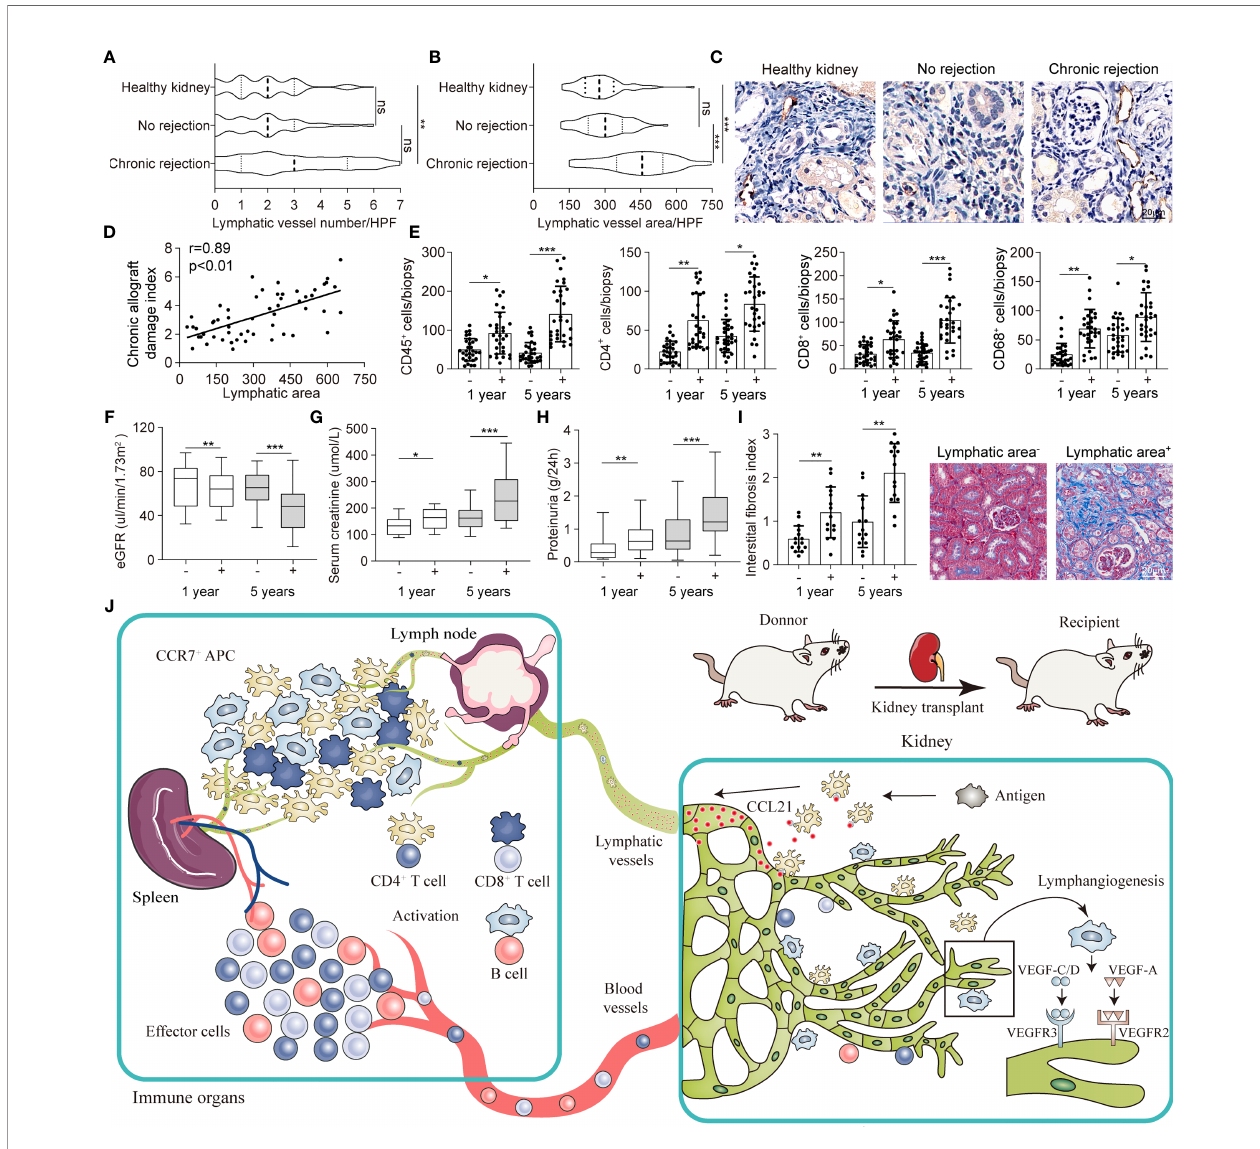
FIGURE 6 | Intrarenal lymphangiogenesis negatively correlated with allograft function in transplant patients. (A, B) Lymphatic vessels number and area counted in high-power fi eld (HPF) respectively in healthy (n=11), no rejection (n=80) and chronic rejection kidneys (n=54) from patients. (C) Representative images of immunohistochemical staining of LYVE-1 in healthy, no rejection and chronic rejection kidneys from patients to identify the situation of lymphangiogenesis. (D) Linear regression graph of chronic allograft damage index and lymphatic area. (E) Cell counting of different immune cells, include CD45 + (myeloid cells), CD4 + (Th cells), CD8 + (CTL cells), CD68 + (macrophage), in lymphatic area + (de fi ned as lymphatic vessels area more than 458.74 m m 2 ) and lymphatic area - (de fi ned as lymphatic vessels area less than 458.74 m m 2 ) group from chronic rejection kidneys at 1 year and 5 years determined by fl ow cytometry. (F) Quantitative data of eGFR ( m L/min/ 1.73m 2 ) in lymphatic area + (n=36) and lymphatic area - (n=18) group from chronic rejection kidneys at 1 year and 5 years. (G) Quantitative data of serum creatinine ( m mol/L) in lymphatic area + and lymphatic area - group from chronic rejection kidneys at 1 year and 5 years. (H) Quantitative data of proteinuria (g/24h) in lymphatic area + and lymphatic area - group from chronic rejection kidneys at 1 year and 5 years. (I) Interstitial fi brosis index in lymphatic area + and lymphatic area - group from chronic rejection kidneys at 1 year and 5 years. Representative image of Masson staining showing the situation of interstitial fi brosis within lymphatic area + and lymphatic area - groups. (J) Schematic diagram concluding the crosstalk between kidney and immune organs in allograft rejection lymphangiogenesis. *P < 0.05, **P < 0.01, ***P < 0.001. Values are mean ±